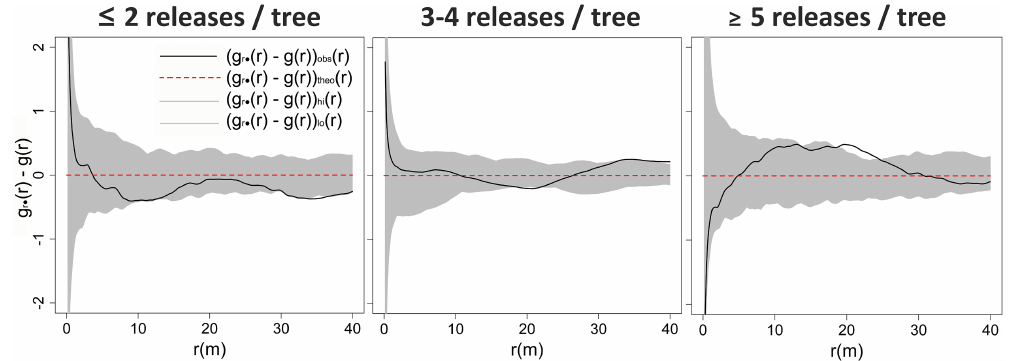
Figure 7. Test statistic for random labelling of releases per canopy trees. We used the “ i -to-any” summary g i • (r) , which is the analogue of the pair correlation function. Under null hypothesis of random labelling ( g r • (r) − g(r)) theo (r) is valid g i • (r) = g(r) . We generated 199 simulations of our null model to obtain pointwise critical envelopes for this model. If the value of statistic ( g r • (r) − g(r)) obs (r) is larger than the value of the ( g r • (r) − g(r)) hi (r) then the releases show significant clustering. If the value of ( g r • (r) − g(r)) obs (r) is smaller than value of the ( g r • (r) − g(r)) lo (r) then the releases show a regular distribution. In the grey zone, we cannot reject the null hypothesis of random labelling. The variable r refers to distance (for details see Sect.